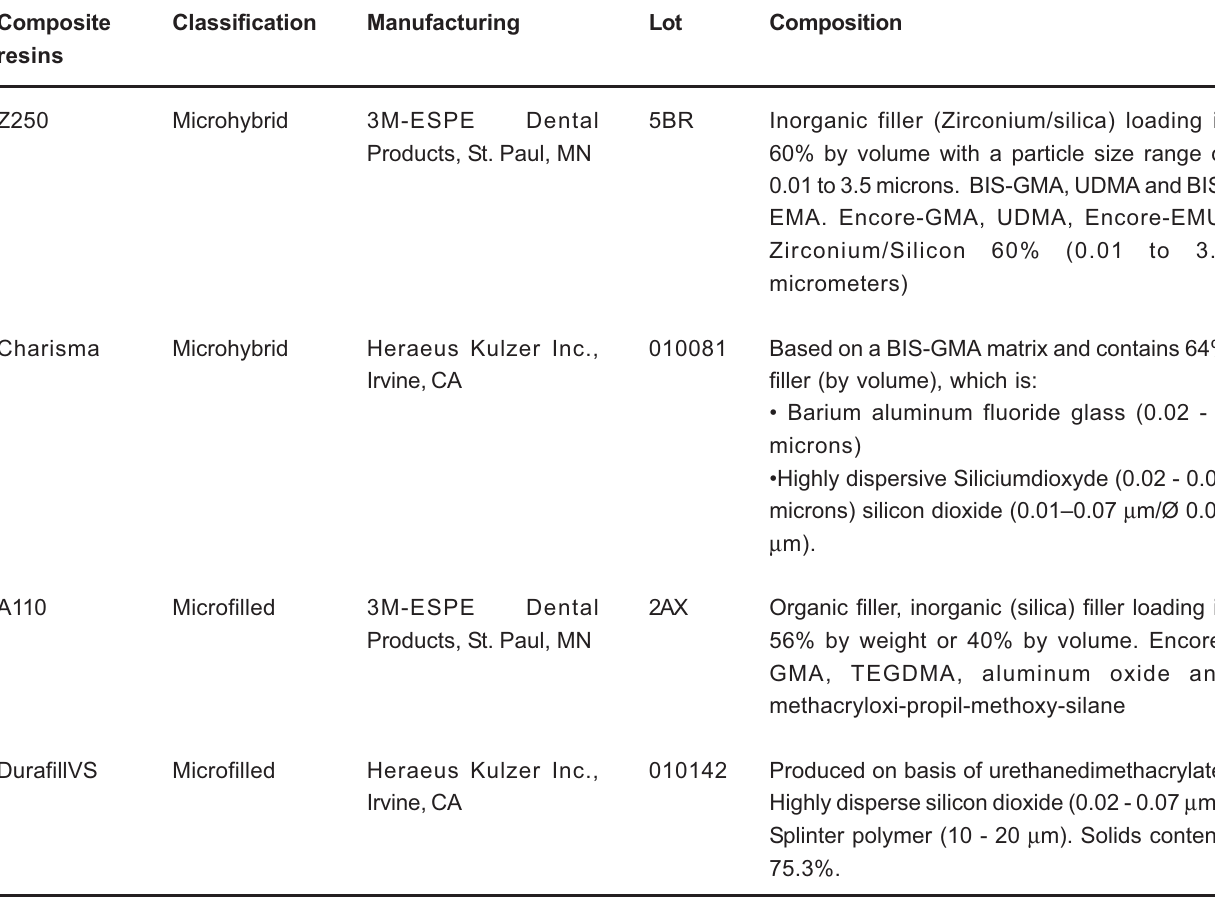
TABLE 1- Composite resins: particle size, manufacturer, lot and composition